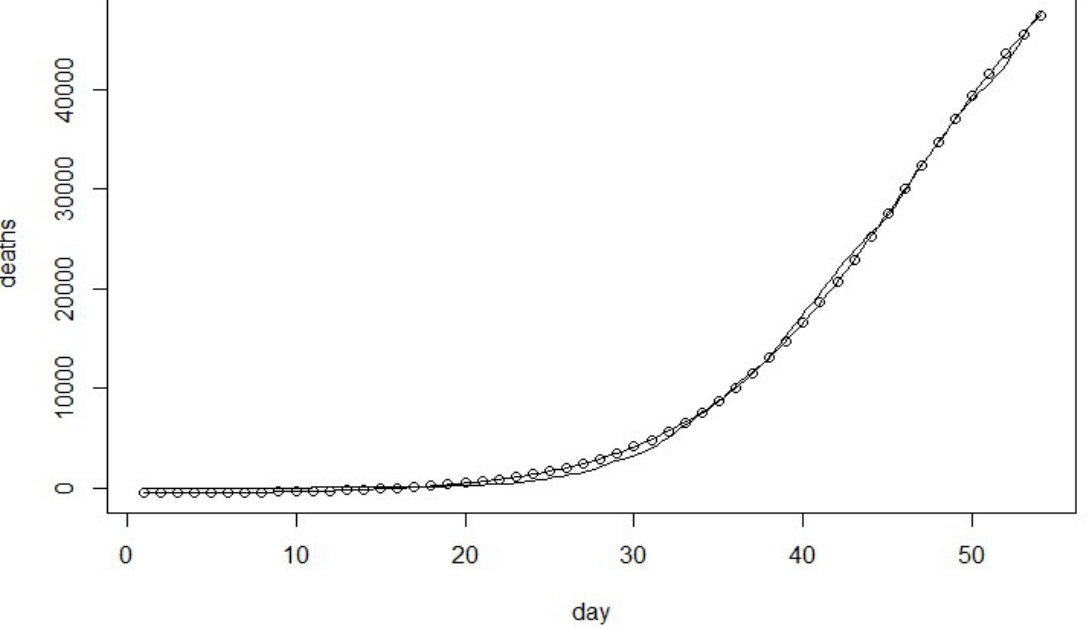
Figure 4. The estimated cumulative number of deaths vs. actual death data from all three models. 4. Conclusions In this paper, an explicit model function to predict the total number of deaths in the population is presented. We also discuss a new criterion that can choose the best model in the set of candidates. The results of the model parameter estimates of the proposed model and two related proposed models using the least squares method for the Covid-19 death data in the U.S. are presented. The proposed model fits significantly better than two other related models based on the Covid-19 death data in the United States. The results show very encouraging predictability for the model.